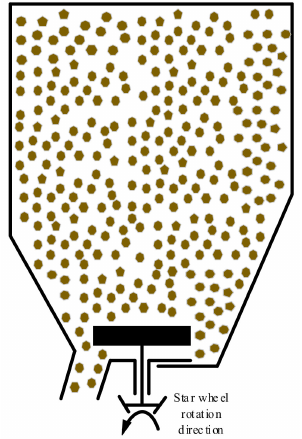
Figure 7. Star wheel fertilizer ejector.